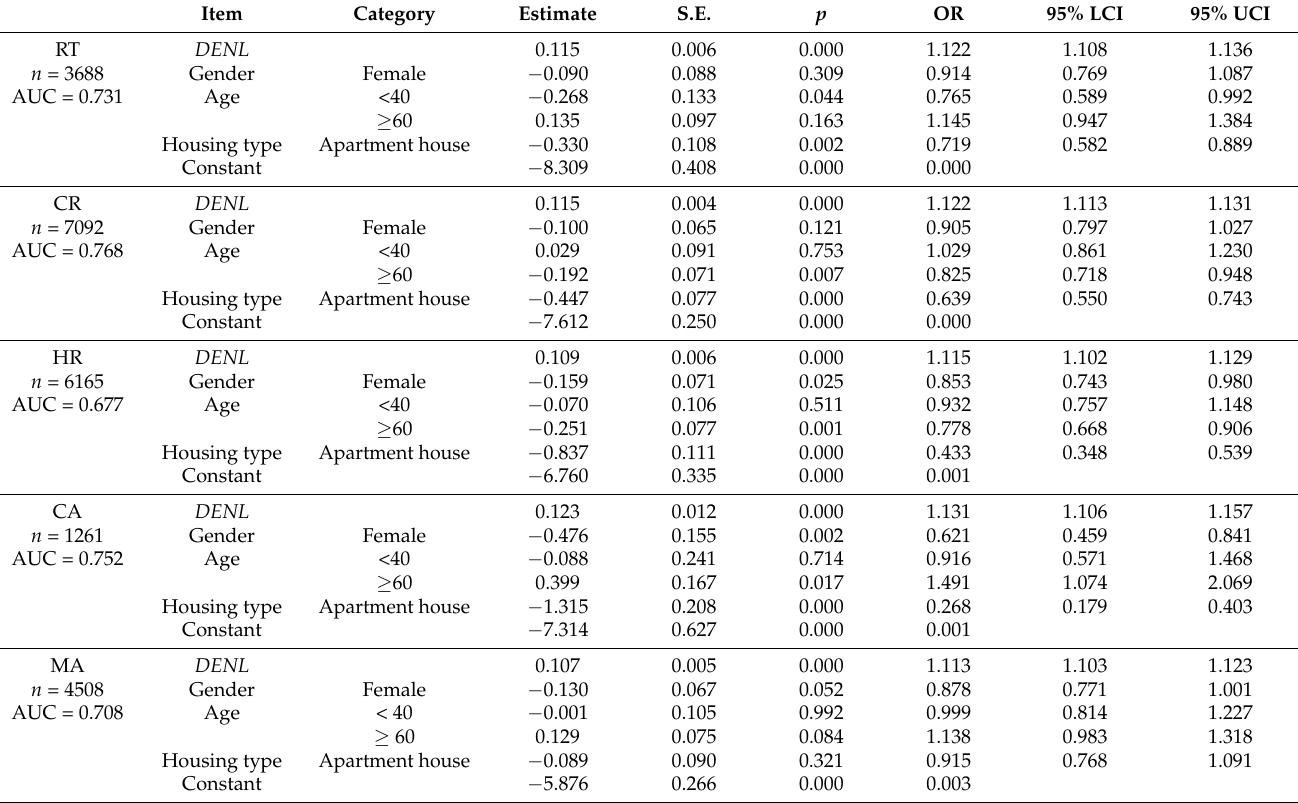
Table 7. Exposure–annoyance relationships for each dataset. Odds ratio (OR) means a change of 1 dB in the noise